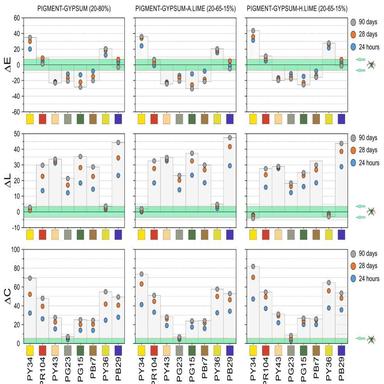
Graphic representation of average values for the total color differences (ΔE), luminosity (ΔL) and saturation (ΔC) between the pure pigments and each of the binders tested in laboratory conditions, in the three phases of the study: after twenty-four hours, twenty-eight days and ninety days.